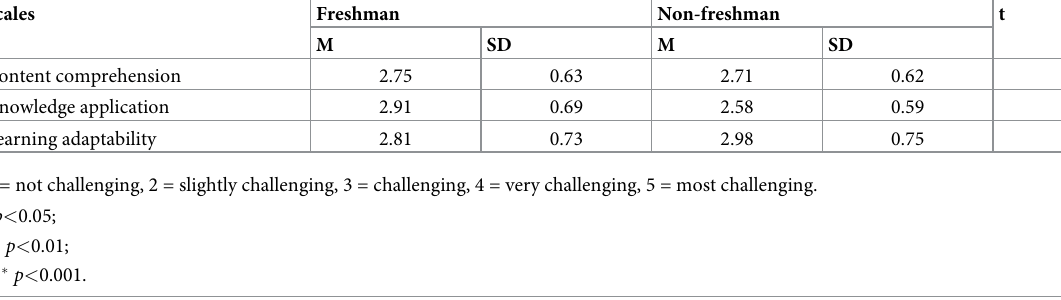
Table 6. Descriptive statistics and t -test results for learning challenges (freshman vs. non-freshman). Scales